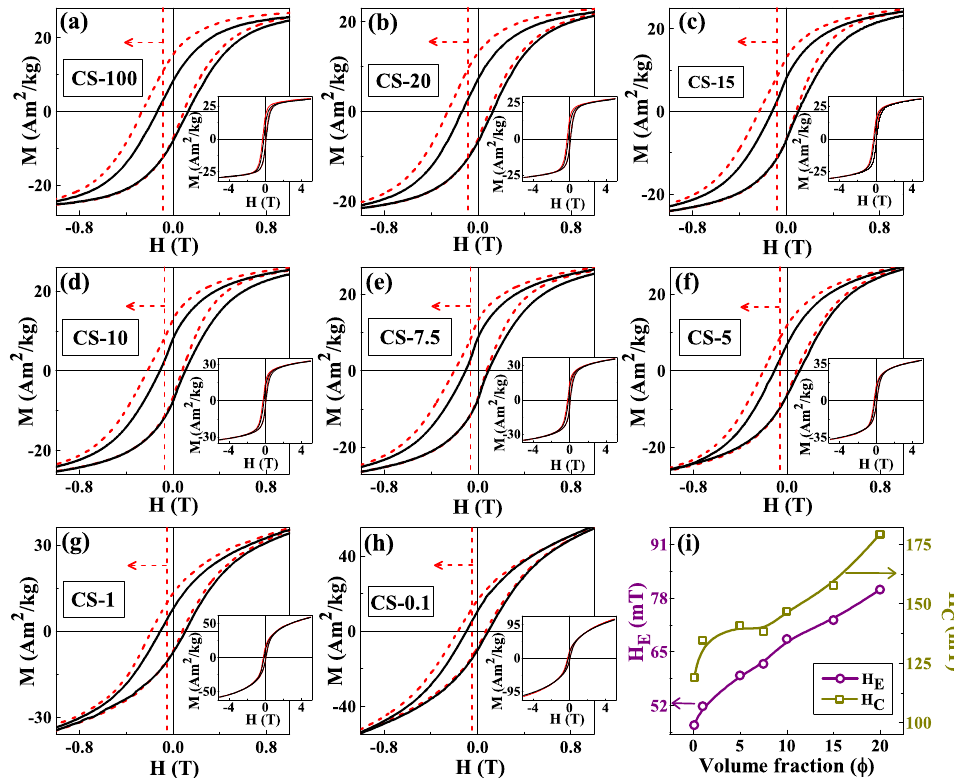
Figure 6. ( a – h ) Central portions of the ZFC (solid line) and in the FC ( H cool = 1 T, dashed line) M − H loops recorded at 4 K for CS-100, CS-20, CS-15, CS-10, CS-7.5 CS-5, CS-1 and CS-0.1. Full scale M − H loops are depicted in the corresponding insets. ( i ) Variation of coercivity ( H C ) and EB field ( H E ) with change in volume fraction ( ϕ